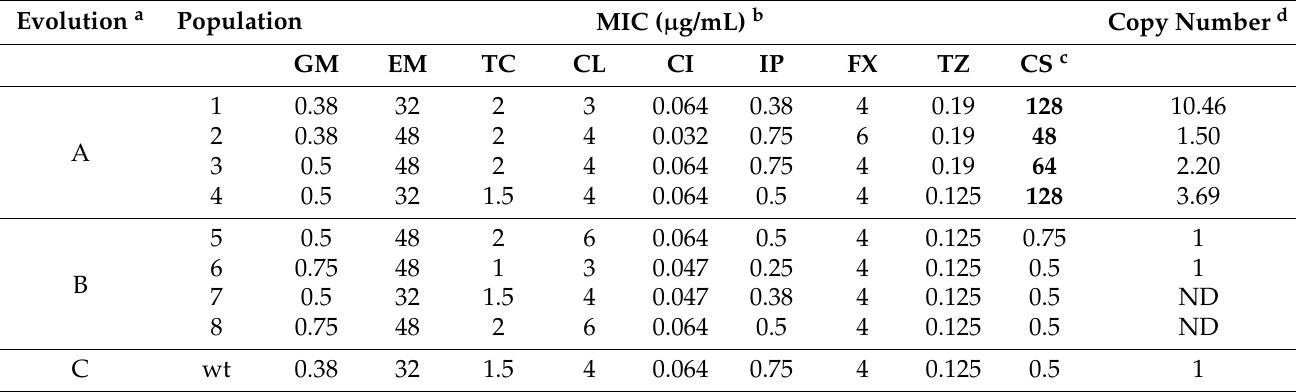
Table 1. Minimal Inhibitory Concentrations (MICs) of different antibiotics for K. pneumoniae evolved in the presence or in absence of